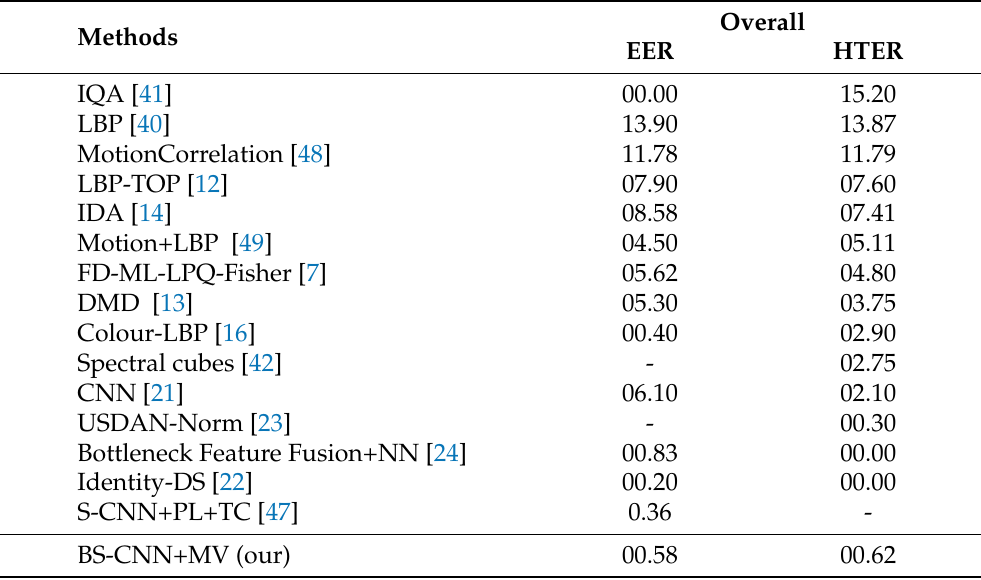
Table 3. Comparison between the proposed countermeasure and the state-of-the-art methods on the REPLAY-ATTACK database.